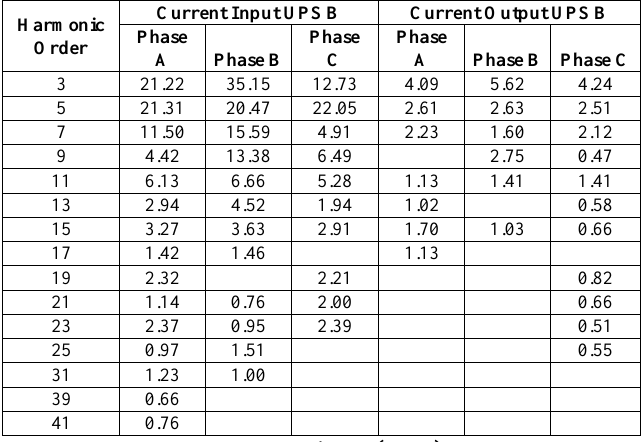
Table 4: Comparison of the current of UPS B. Harmonic Order